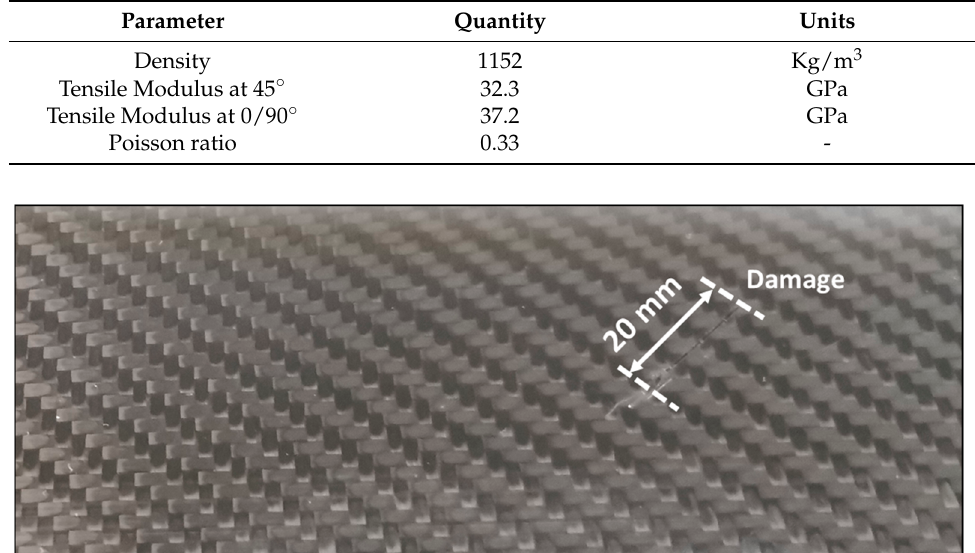
Table 1. Mechanical proprieties of the CFRP specimen.